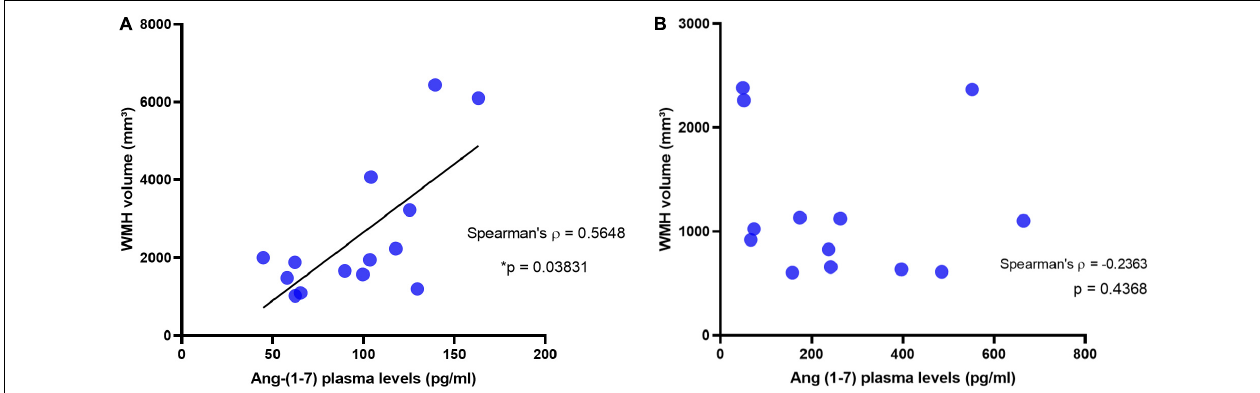
FIGURE 2 | Correlation between White Matter Hypointensities and Plasma Levels of Ang-(1–7) in AD patients and in controls. White matter hypointensities volumes positively correlated with Ang-(1–7) in AD patients (A) , but not in controls (B) . TABLE 2 | Correlations between MRI variables and plasma angiotensins in AD patients and controls. Plasma Ang II Plasma Ang-(1–7) Ang-(1–7)/Ang II ratio Spearman’s rho coefficient (95% confidence